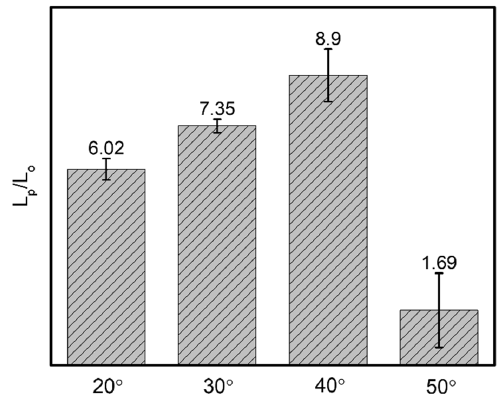
Figure 14. The ratio presents the predominant wetting distance (L p ) to the opposite one (L o ) corre- sponding to various β angles.